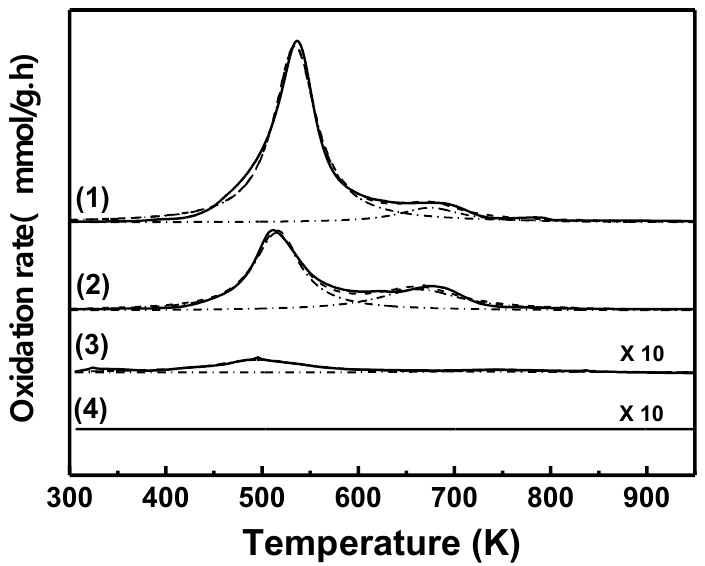
Figure 9. Temperature-programed oxidation (TPO) profiles of Cu/SiO 2 -PD catalyst. (1) Used catalyst;